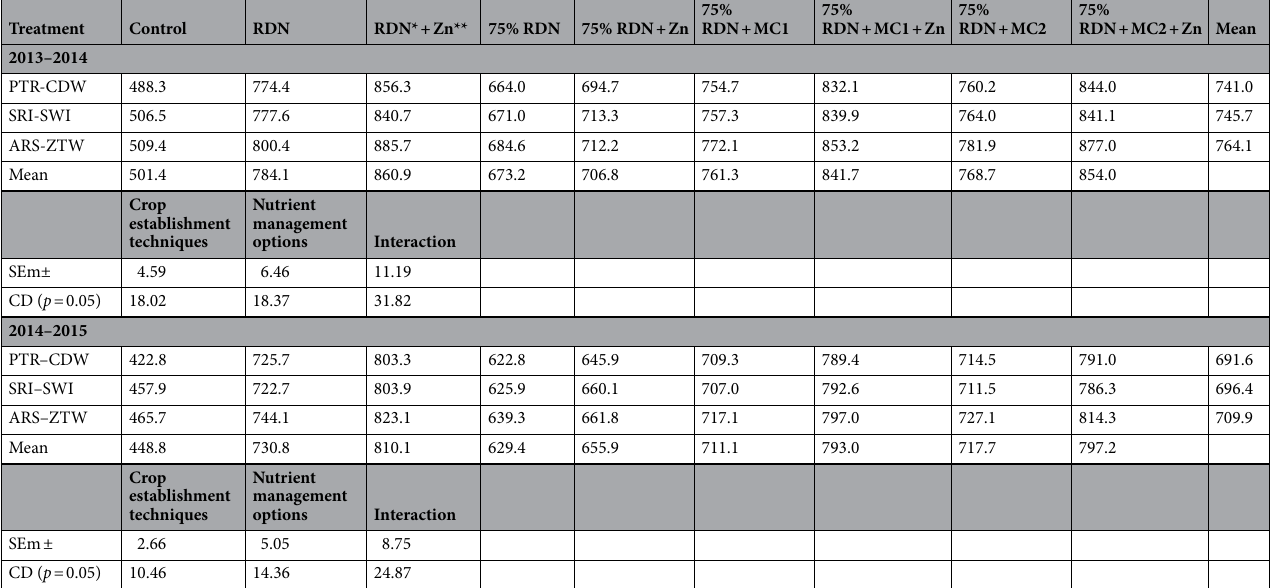
Table 5. Influence of crop establishment techniques and nutrient management options on zinc uptake (g ha −1 ) in rice–wheat cropping system during 2013–2014 and 2014–2015. PTR , puddled transplanted rice; SRI , system of rice intensification; ARS , aerobic rice system; CDW , conventional drill-sown wheat; SWI , system of wheat intensification; ZTW , zero tillage wheat; RDN* , recommended dose of nutrients [120 kg nitrogen ha −1